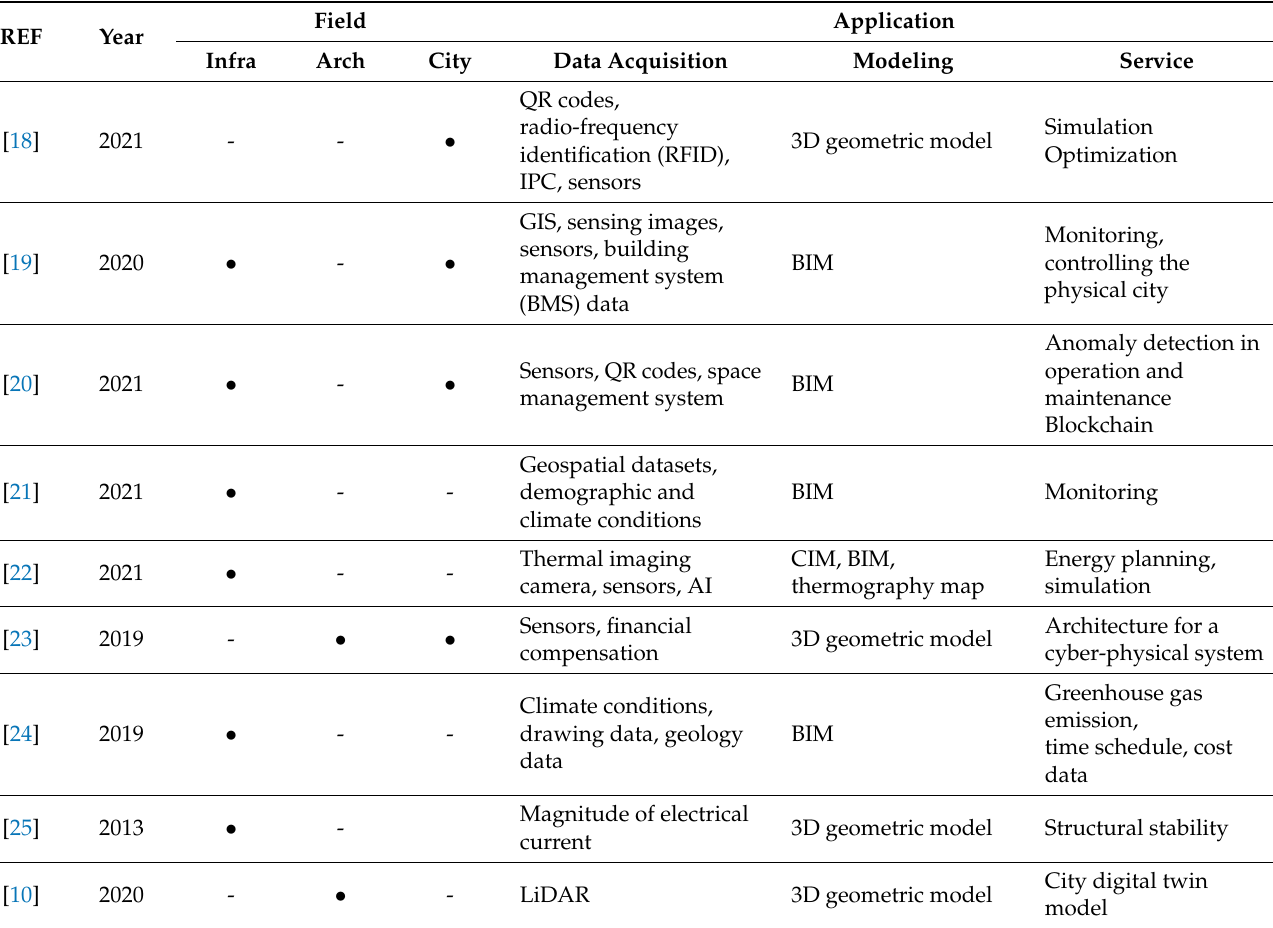
Table 1. Previous research cases on digital twins in the construction